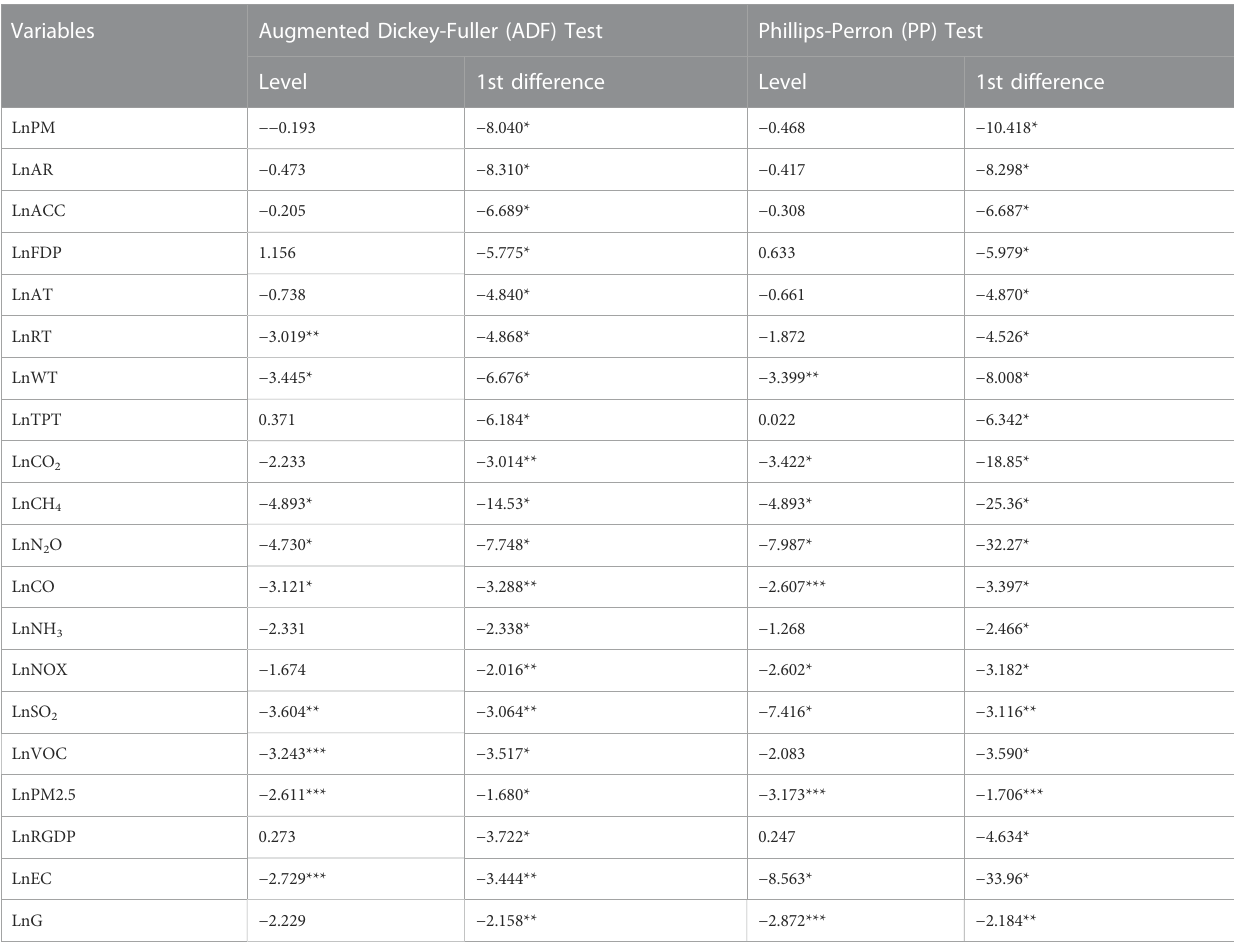
TABLE 3 Unit root -ADF and PP tests- results.